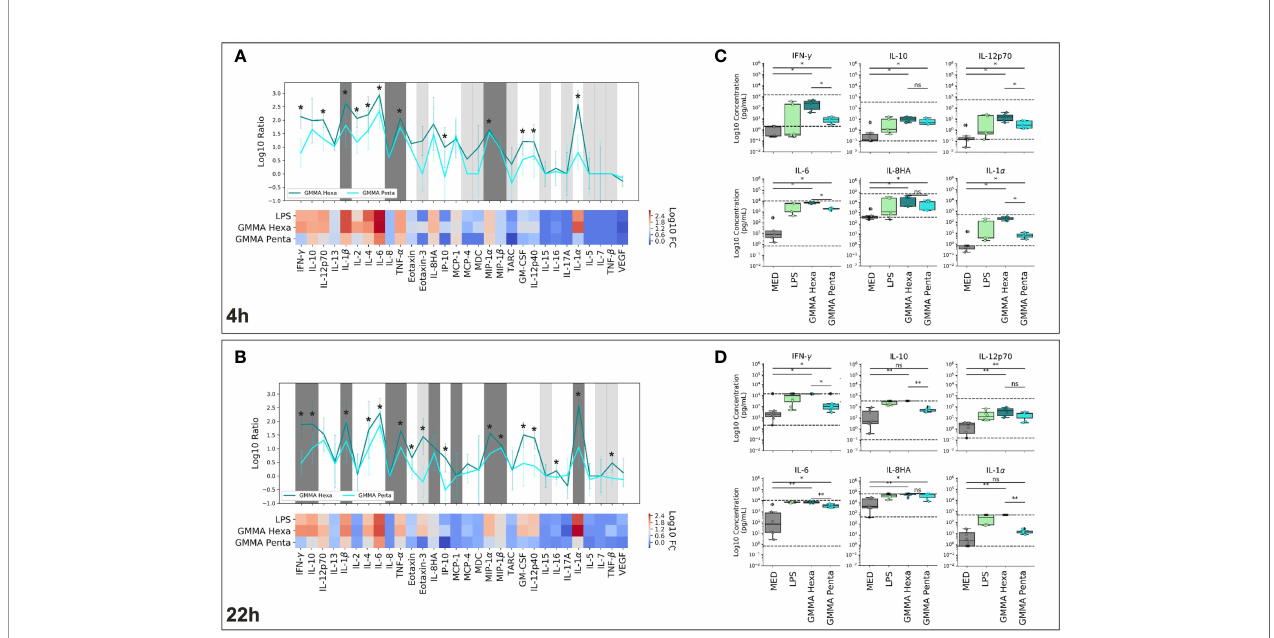
FIGURE 1 | Cytokine levels in the supernatants of hPMBCs stimulated with S. sonnei GMMA. (A, B) Cytokine expression pro fi le of GMMA Hexa, GMMA Penta, and LPS after 4 hours (A) and 22 hours (B) incubation. Results are expressed as log 10 of the median fold change (log 10 FC) over the six donors compared to the non- stimulated samples. Heatmaps show the relative cytokine levels. Line plots further illustrate the comparison between GMMA Hexa (dark cyan) and GMMA Penta (light cyan). Lines mark the median log 10 FC, while error bars represent the standard deviation over the donors. Dark gray and light gray areas indicate cytokines whose expression falls respectively above/below the upper/lower limit of detection (ULOD/LLOD) for more than 50% of the donors. For these cytokines, values were substituted respectively with ULOD or LLOD. (C, D) Comparison of cytokine concentrations after 4 (C) and 22 hours (D) incubation with GMMA Hexa (dark cyan), GMMA Penta (light cyan), or LPS (green). Non-stimulated samples are shown as reference in gray (MED). Dots show the results for each of the donors. Concentrations out of the detection range were replaced with the detection limits. Dashed black lines indicate the upper and lower limits of detection. The Mann-Whitney test with Benjamini-Hochberg correction was used to determine the signi fi cance of the observed differences (*p-value < 0,05, **p-value<0.005; ns stands for nonsigni fi cant, p-value >